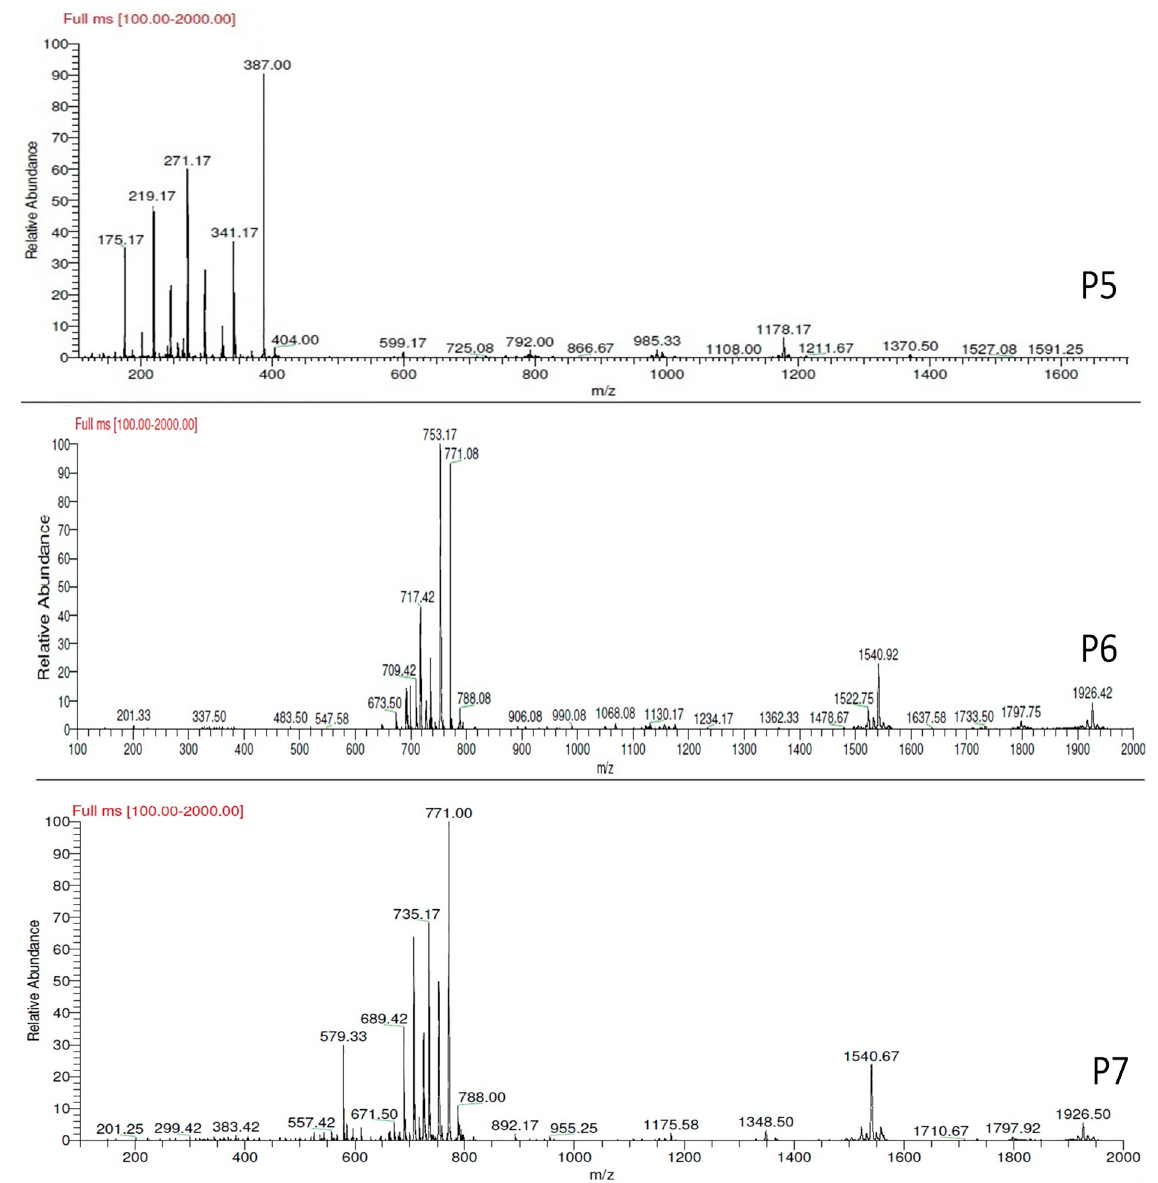
Figure 2. LC-MS spectrum (Full scan) of FA and its products in positive ion